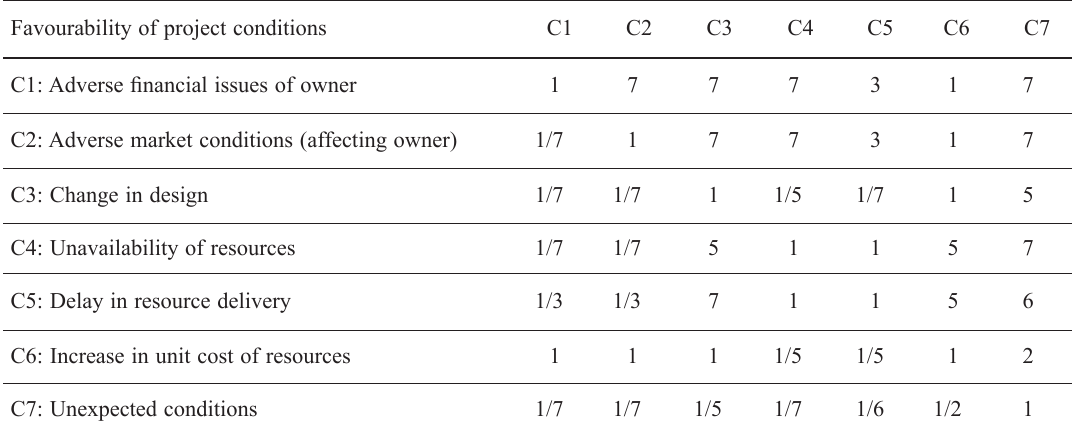
Table 3. Relative importance weight of project conditions with respect to favourability of project conditions Favourability of project conditions